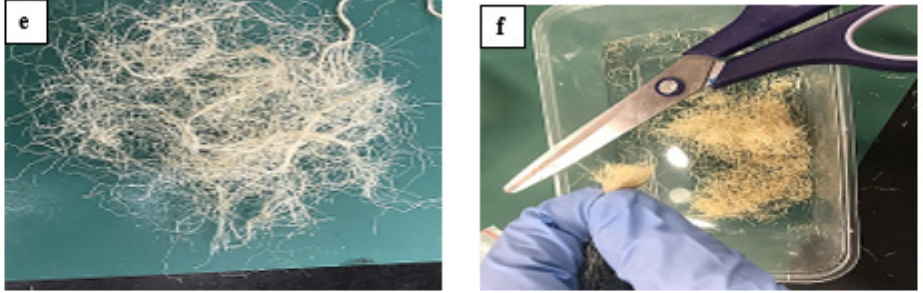
Figure 3. Different steps in the preparation of sisal fibres ( a ) unwinding, ( b ) sizing, and, ( c ) cutting ( d , e ) separation and ( f ) small manageable pieces.